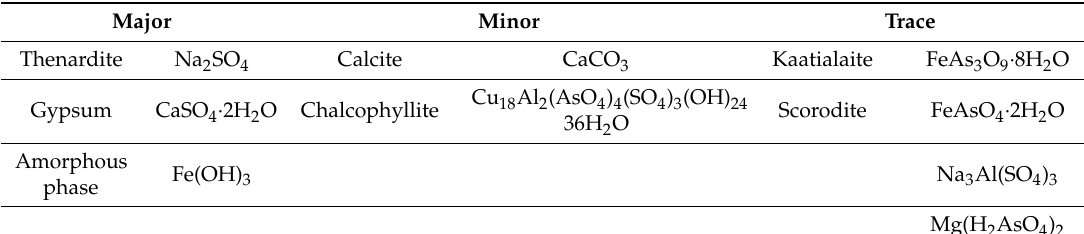
Table 7. Mineral composition of the precipitates after the experiment with NaOH (XRD analysis). Major